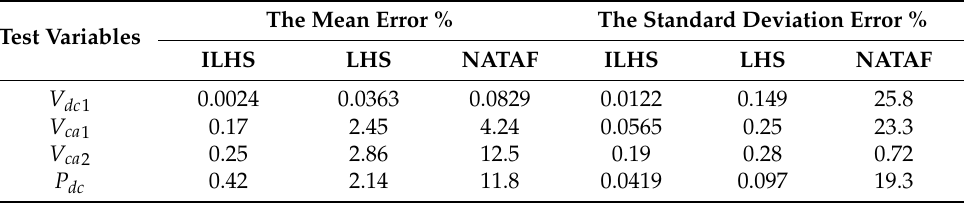
Table 2. The mean and standard deviation errors of the parameters at the VSC stations.